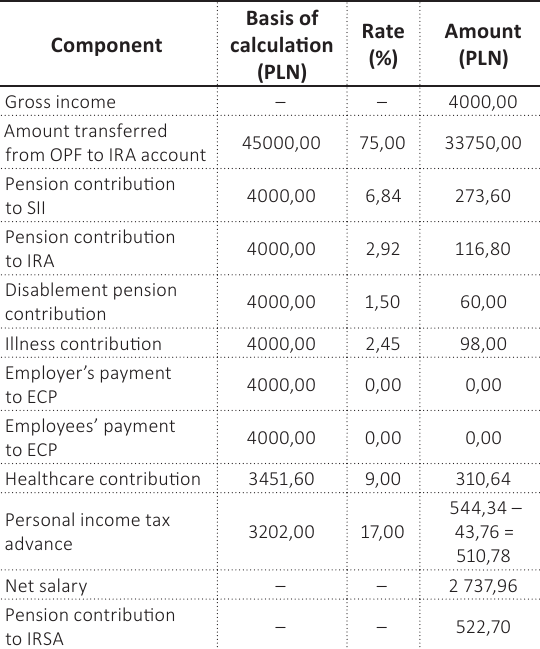
Table 9. Variant 3 – non-participation in ECP and non-member of IRA